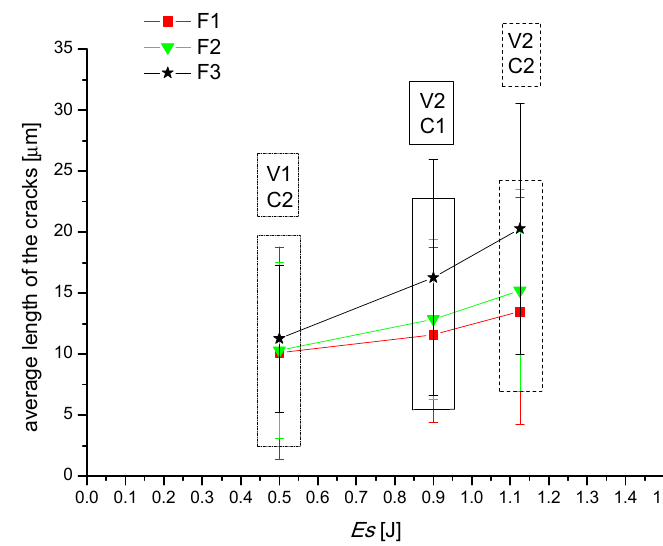
Figure 16. Effect of spark pulse-energy Es on average cracks length that propagate in the substrate from the deposit/substrate interface for three different values of frequency (F1 < F2 < F3).